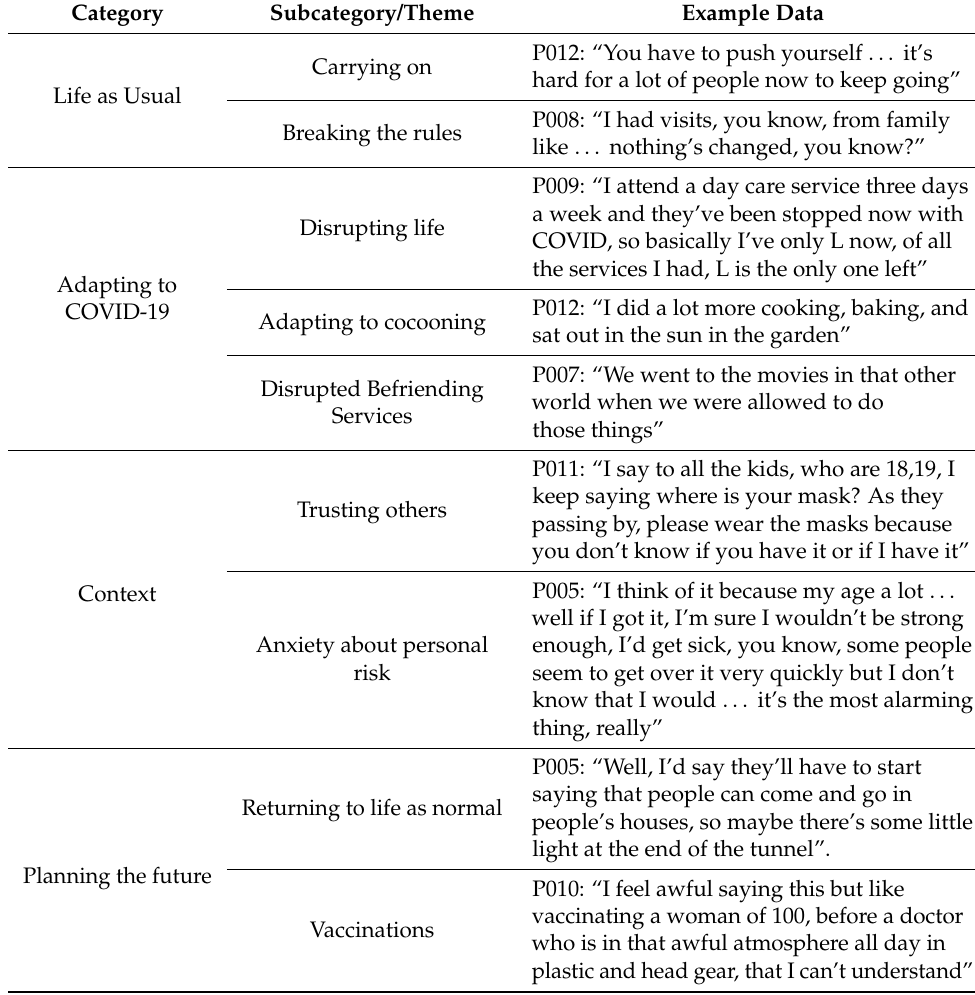
Table 2. Categories and subcategories/themes presented in the grounded theory “maintaining personal